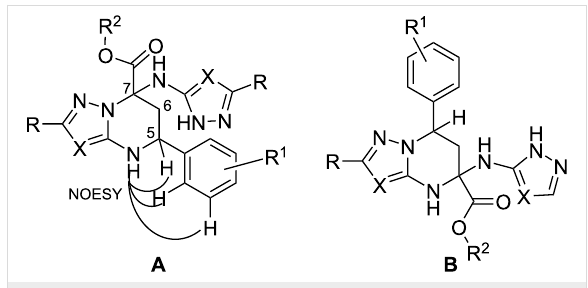
Figure 1: Alternative structures A and B for the tetrahydroazolopyrim- idines 4